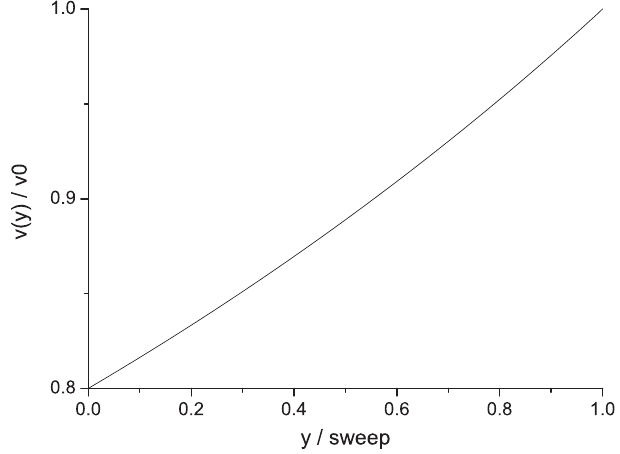
FIG. 2. The ideal velocity of beam ions exiting the wedge at different y positions for a 20% velocity gradient.